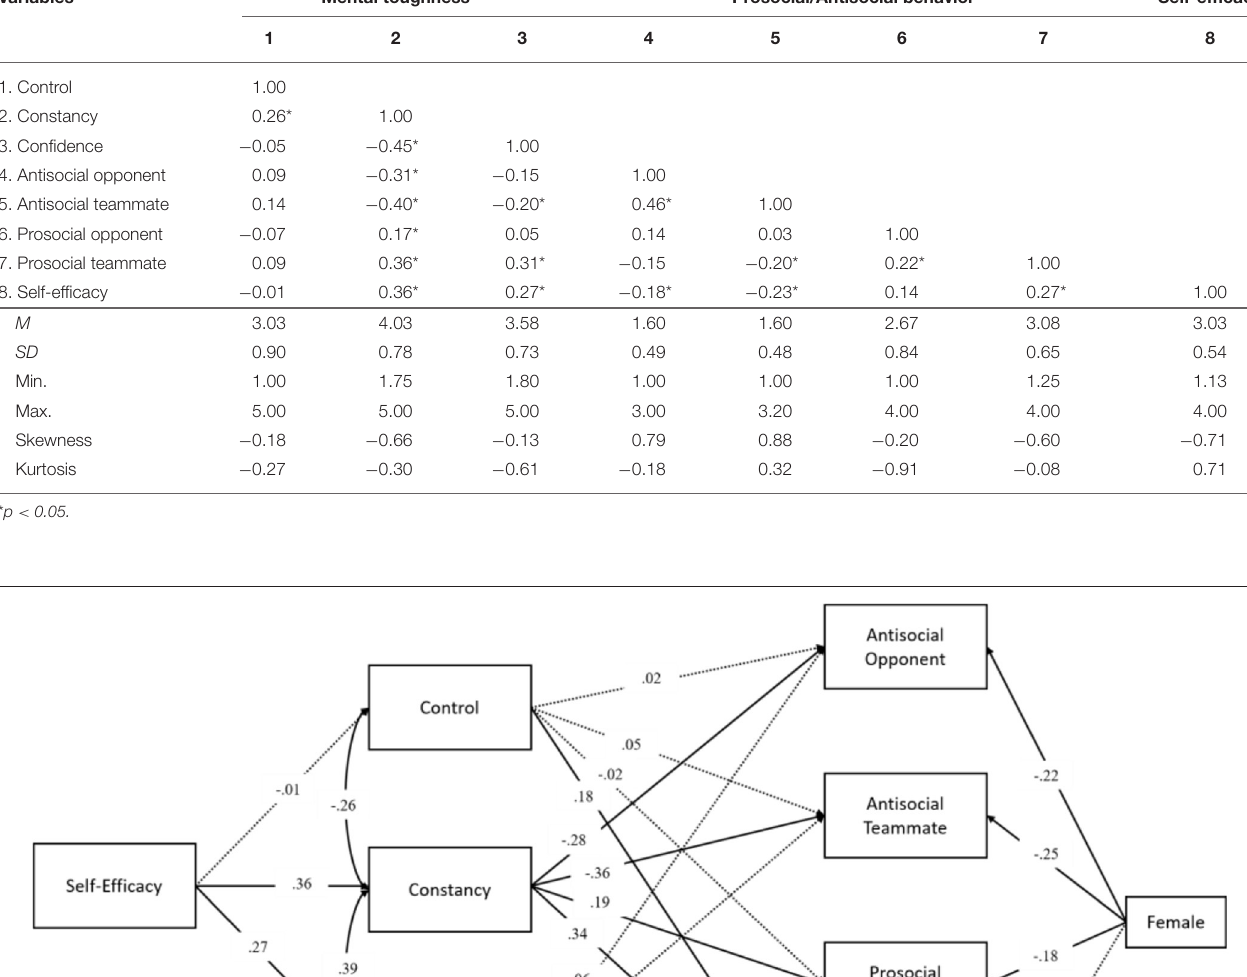
TABLE 2 | Descriptive statistics and correlation coefficients among variables ( N = 158). Variables